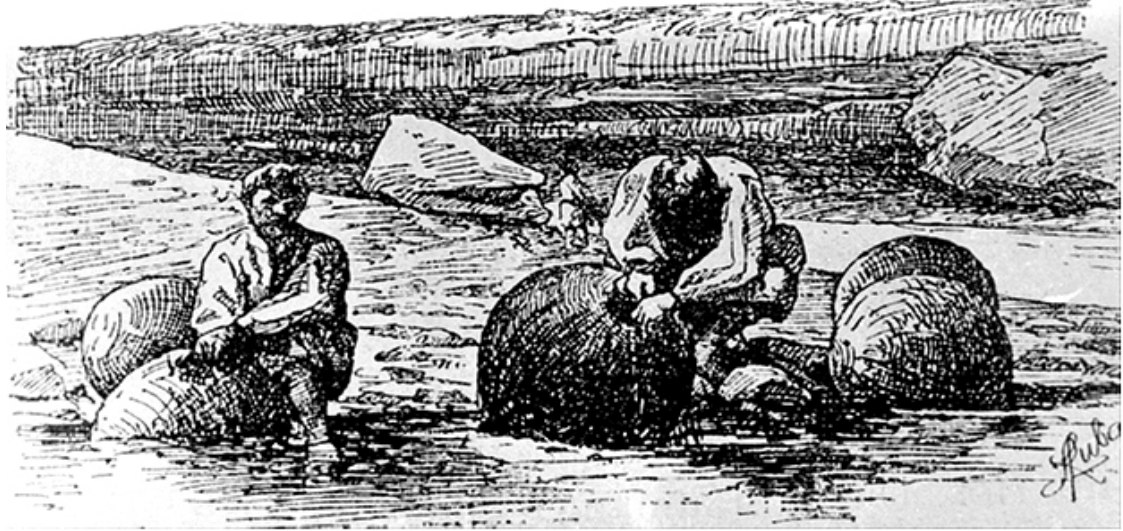
Figure 9. Fisherman in Zeta by L Kuba (1890).